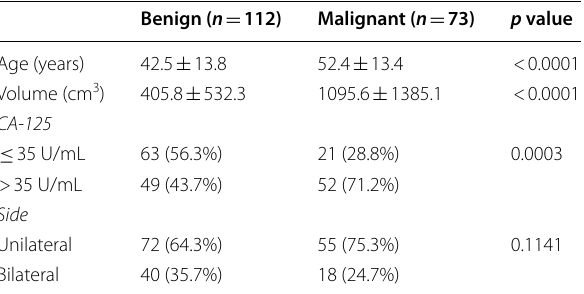
Table 1 Patient and tumor characteristics for the benign and malignant groups